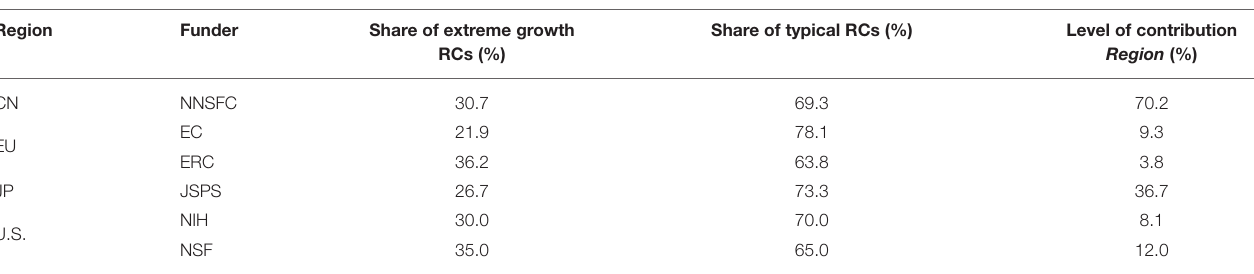
TABLE 5 | Funding organization participation in extreme growth AI research clusters (RCs). Region